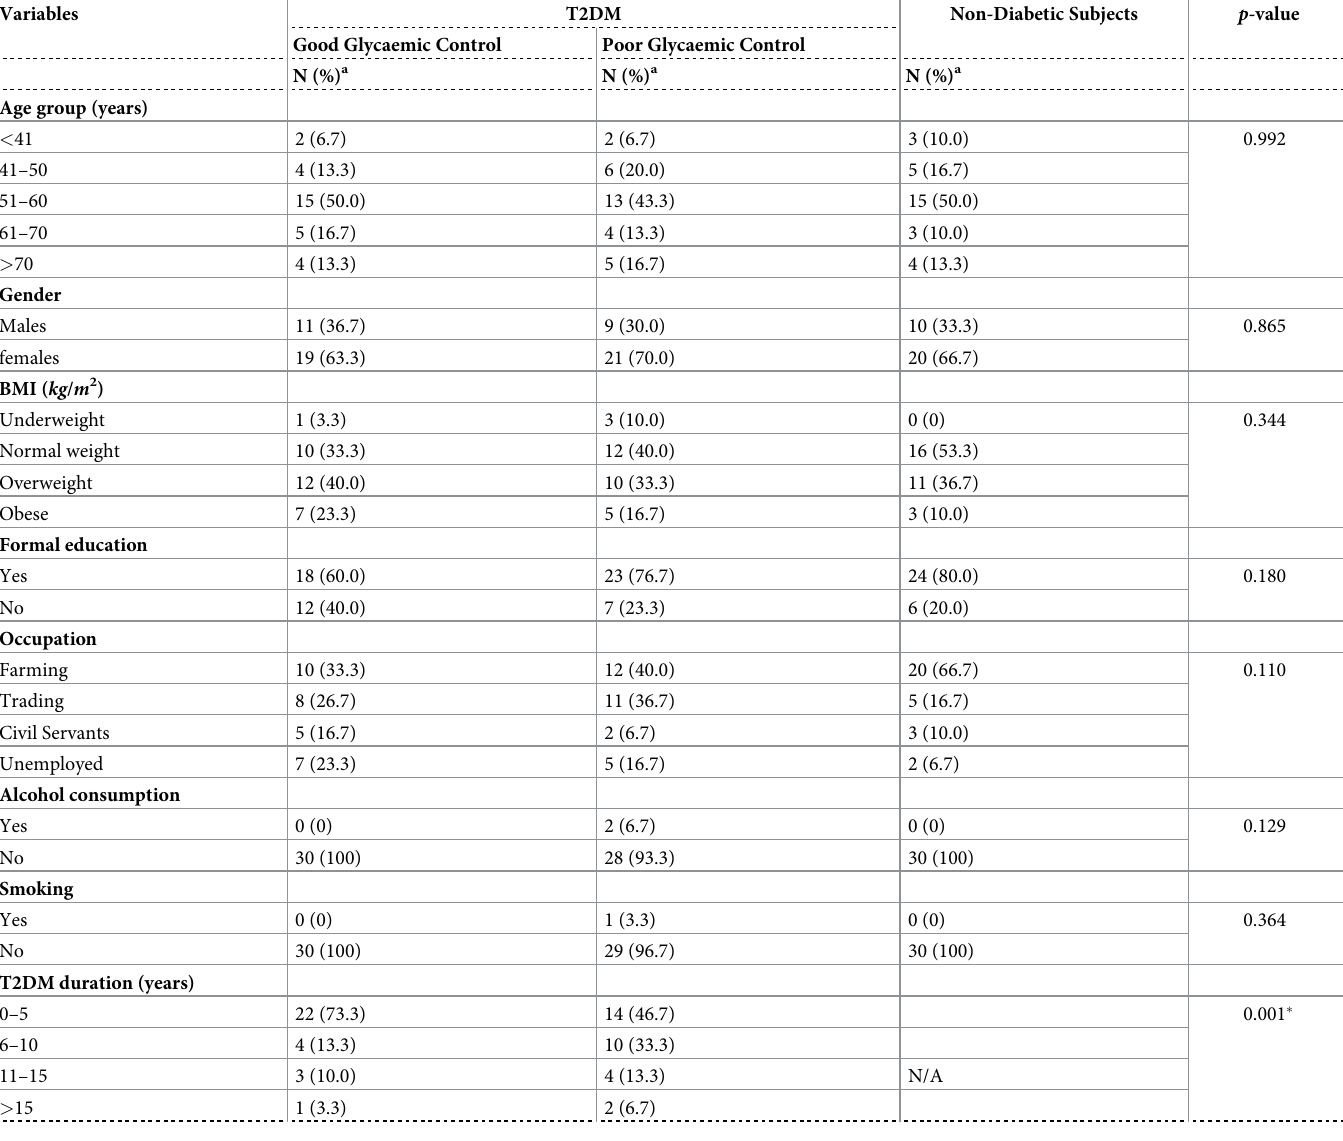
BMI = Body mass index, T2DM = Type 2 diabetes mellitus.